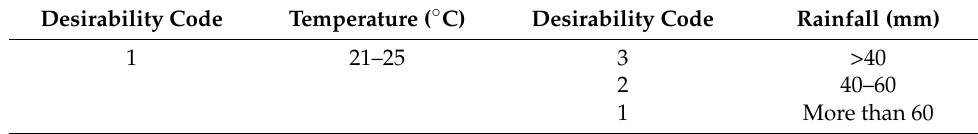
Table 3. Classification and coding of precipitation and temperature factors.